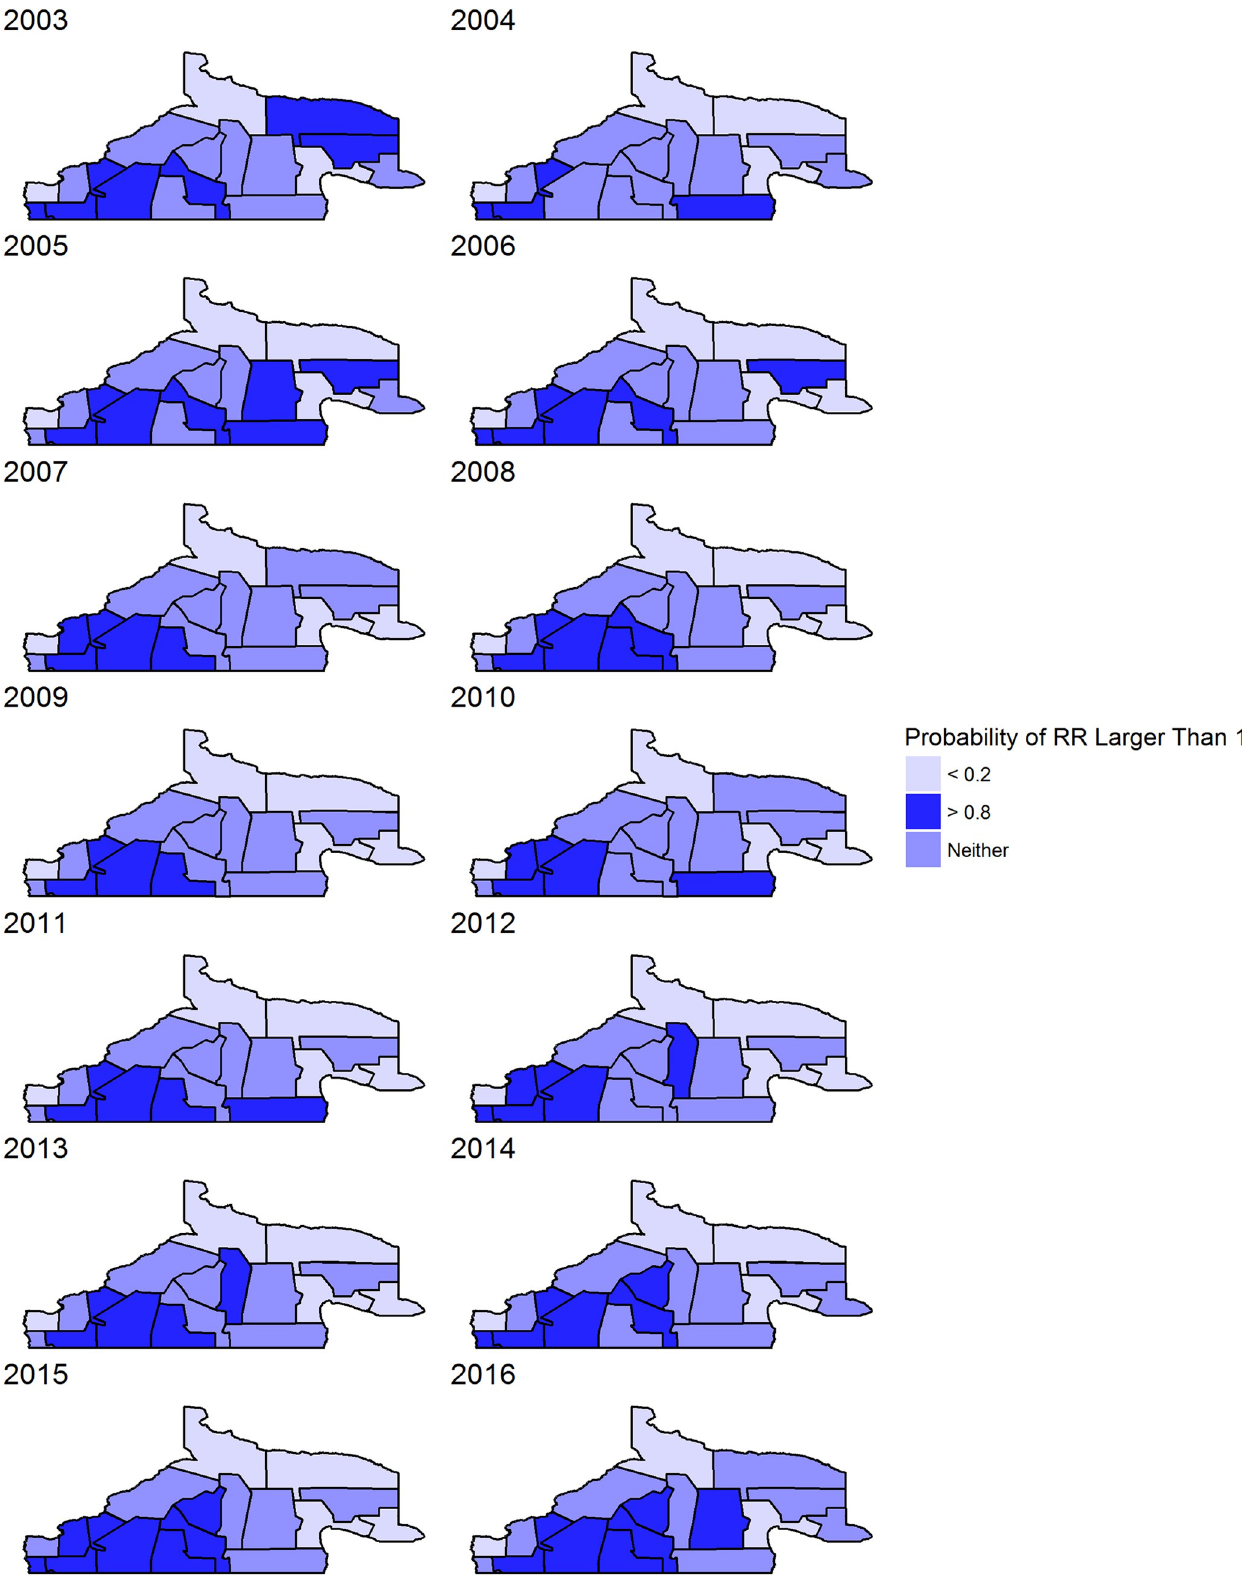
Fig 5. Posterior exceedences for relative risks from model 1.1a. https://doi.org/10.1371/journal.pntd.0008545.g005 PLOS NeglectedTropical Diseases | https://doi.org/10.1371/journal.pntd.0008545 August 25,